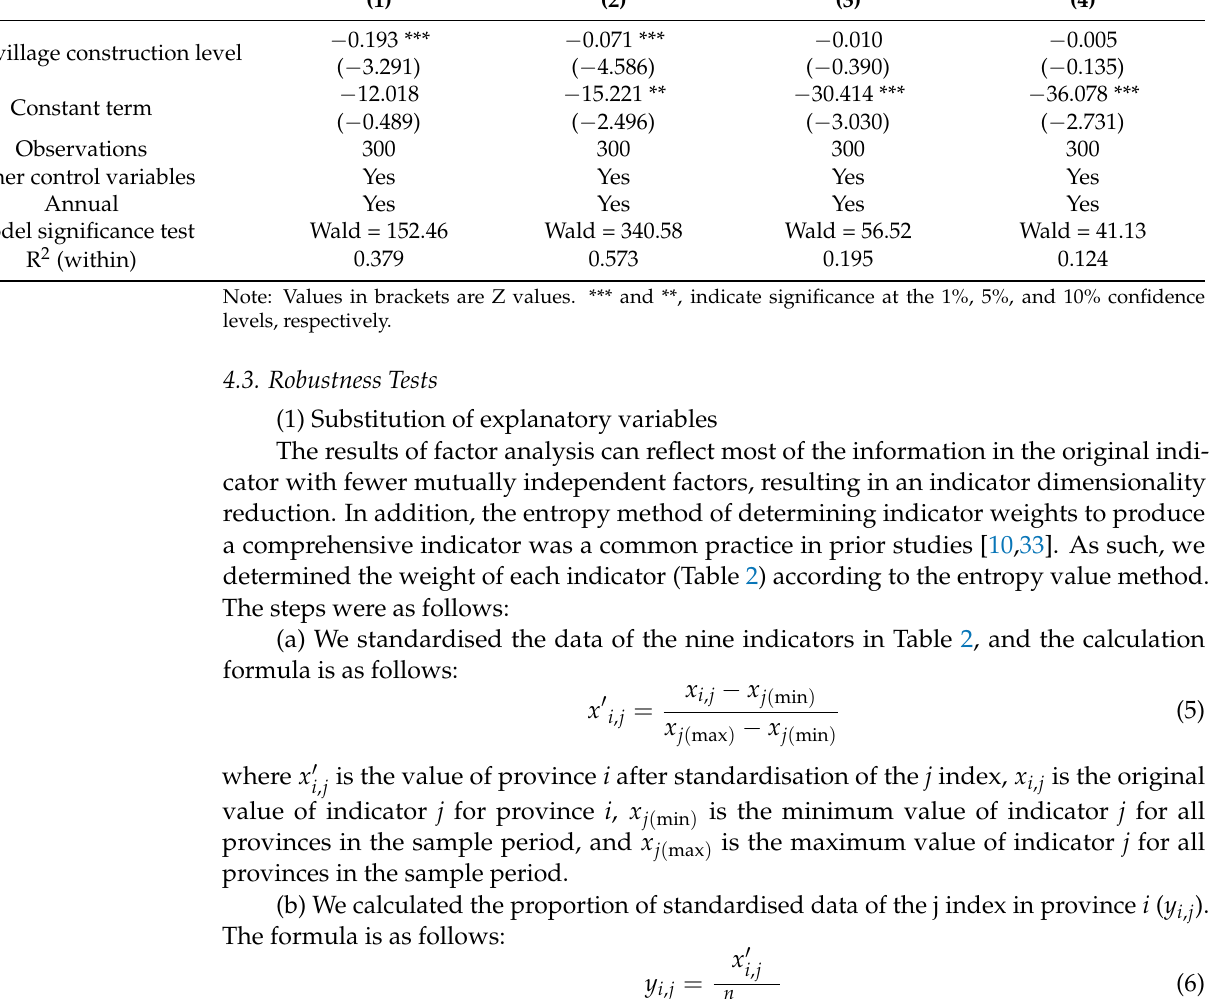
Table 7. Impact of digital village construction on carbon emissions from four aspects of agriculture.